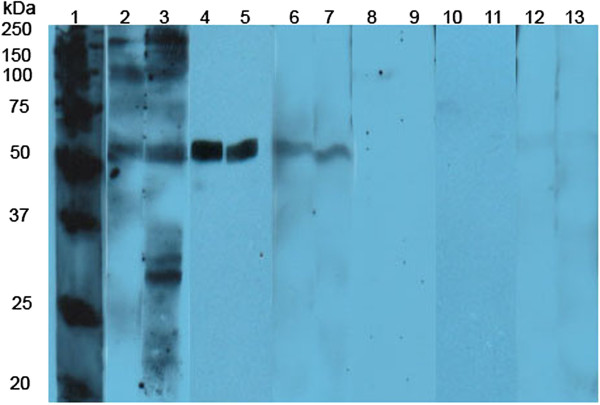
Representative IgG, IgG1and IgG4blots of rGal/GalNAc lectin probed with human serum samples. Lane 1: Precision Plus Protein™ Unstained Standard Marker (Bio-Rad, USA); Lanes 2 to 3: individual serum samples from patients with ALA probed with IgG; Lanes 4 to 5: individual serum samples probed from patients with ALA probed with IgG1, Lanes 6 to7: individual serum samples from patient with ALA probed with IgG4; Lanes 8, 10 and 12: negative serum samples from healthy individuals probed with IgG, IgG1 and IgG4, respectively; Lanes 9, 11 and 13: negative serum samples from other disease probed with IgG, IgG1 and IgG4, respectively.